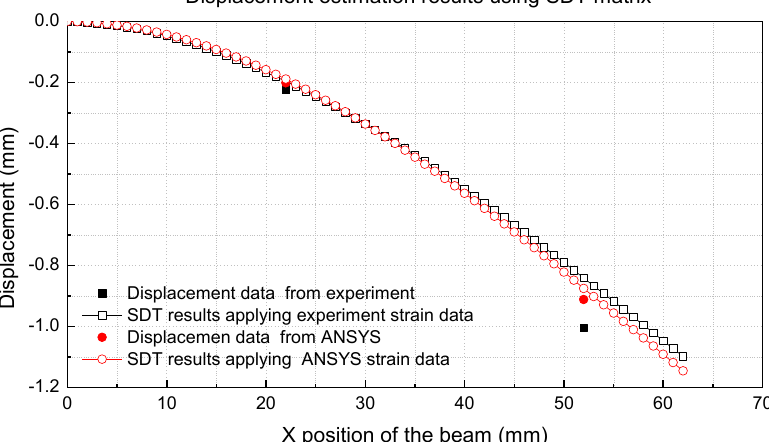
Figure 11. Test setup for deformation and strain estimation experiment for the multilayer beam.